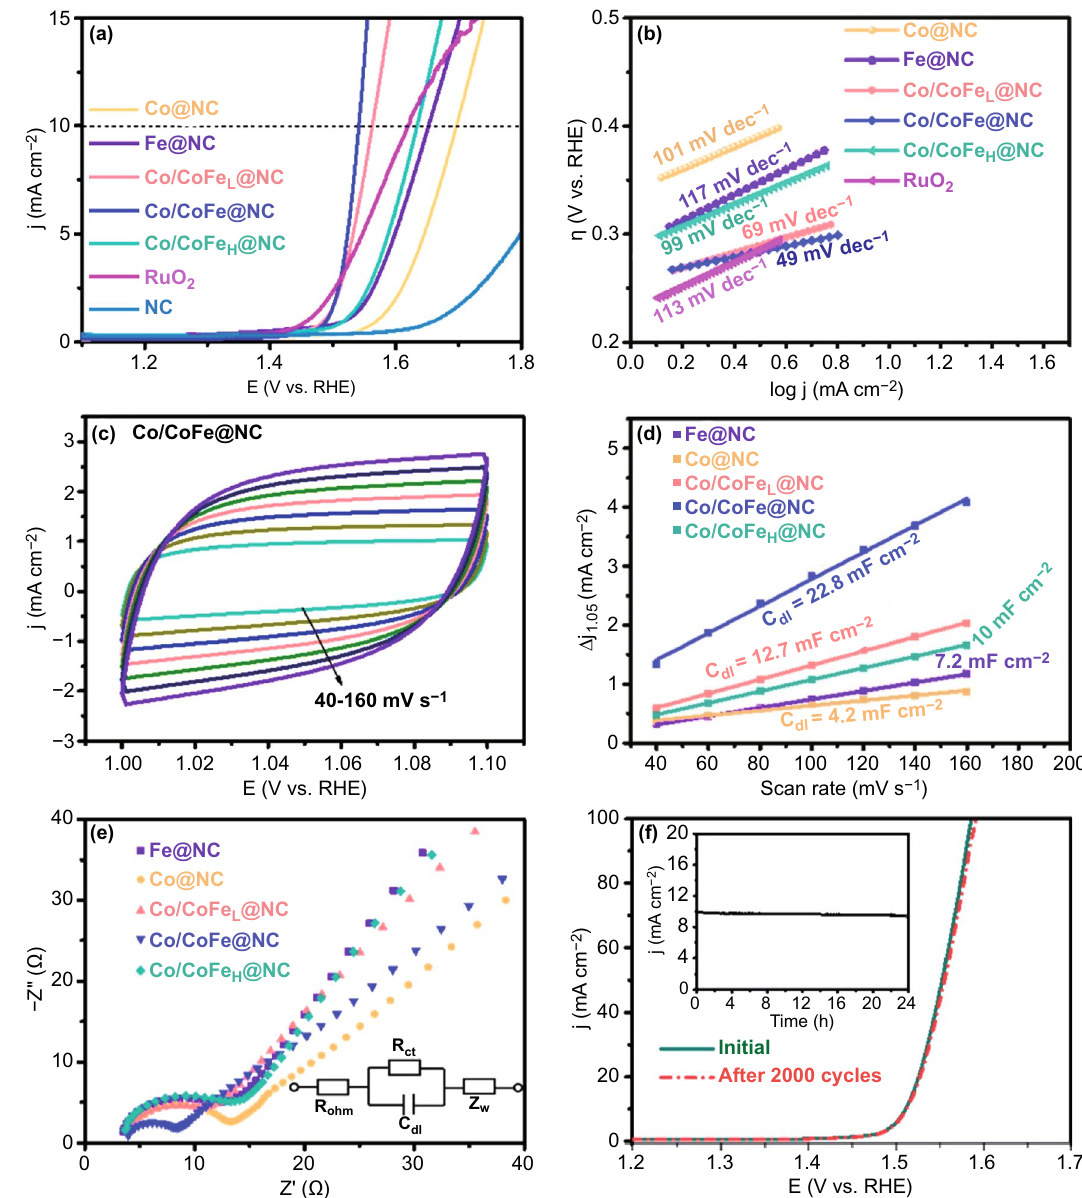
Fig. 4 a OER polarization curves and b corresponding Tafel slopes of the as‑prepared catalysts and RuO 2 in 1 M KOH. c CV curves of Co/ CoFe@NC in the double layer region at different scan rates. d Current density difference (Δj) at 1.05 V plotted against scan rates of various Co/ CoFe x @NC samples. e EIS spectra recorded at a constant overpotential of 150 mV (inset: equivalent circuit, where R ohm is ohmic resistance, R C Z ct is charge‑transfer resistance, dl is interfacial capacitance and w is warburg diffusion impedance). f Polarization curves for Co/CoFe@NC before and after 2000 CV cycles; the inset shows the long‑term electrolysis curve of Co/CoFe@NC at an overpotential of 300